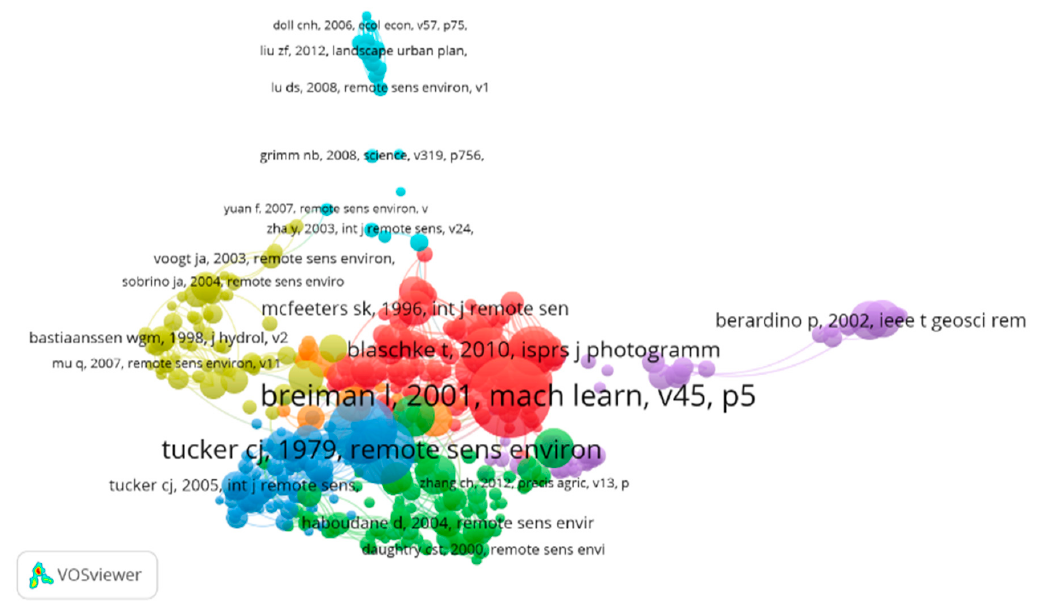
Figure 9. Panorama of intellectual structure of the 764 publications that were cited 20 times or more in Remote Sensing Open Access Journal during 2009–2018 time-period.